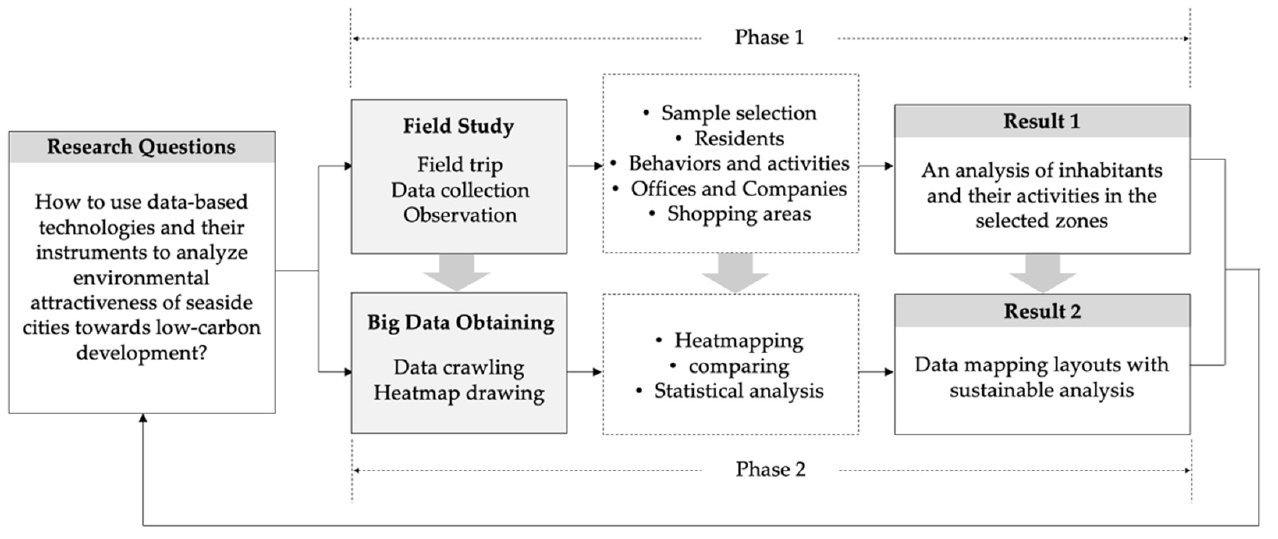
Figure 1. Methodology framework. Source: Authors.